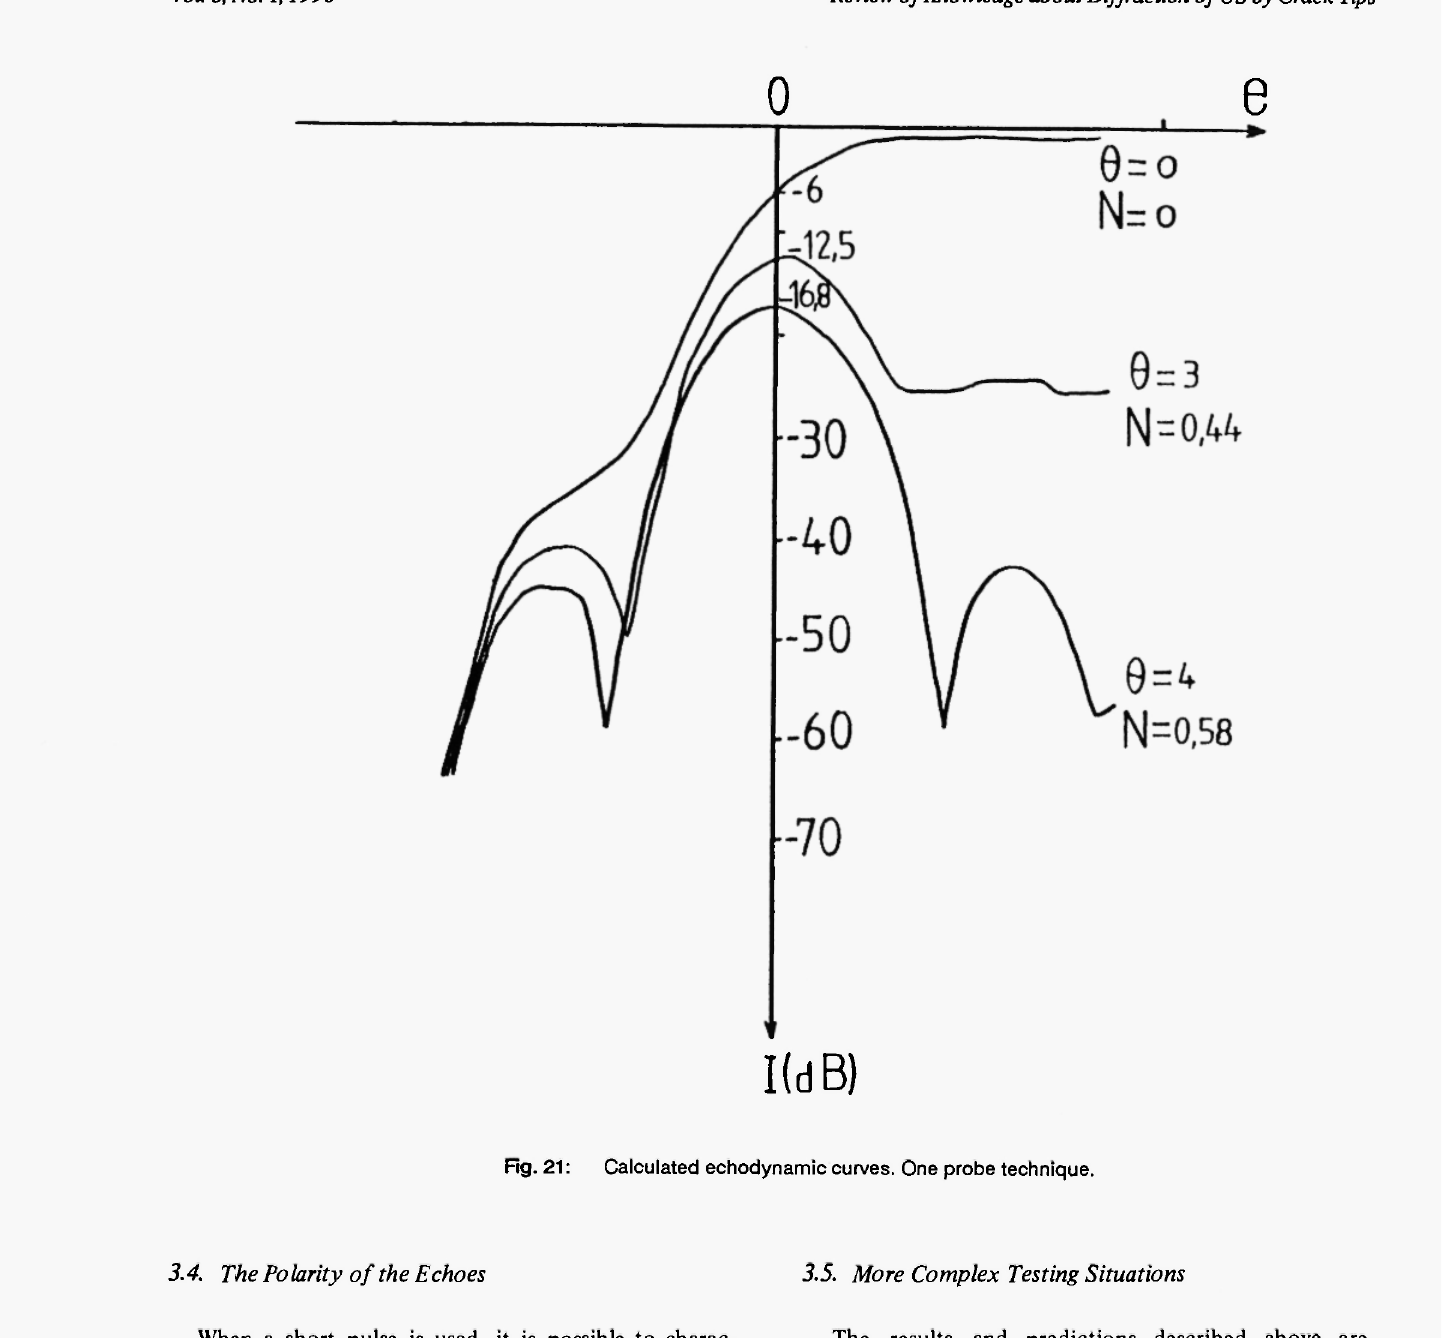
Rg. 21: Calculated echodynamic curves. One probe